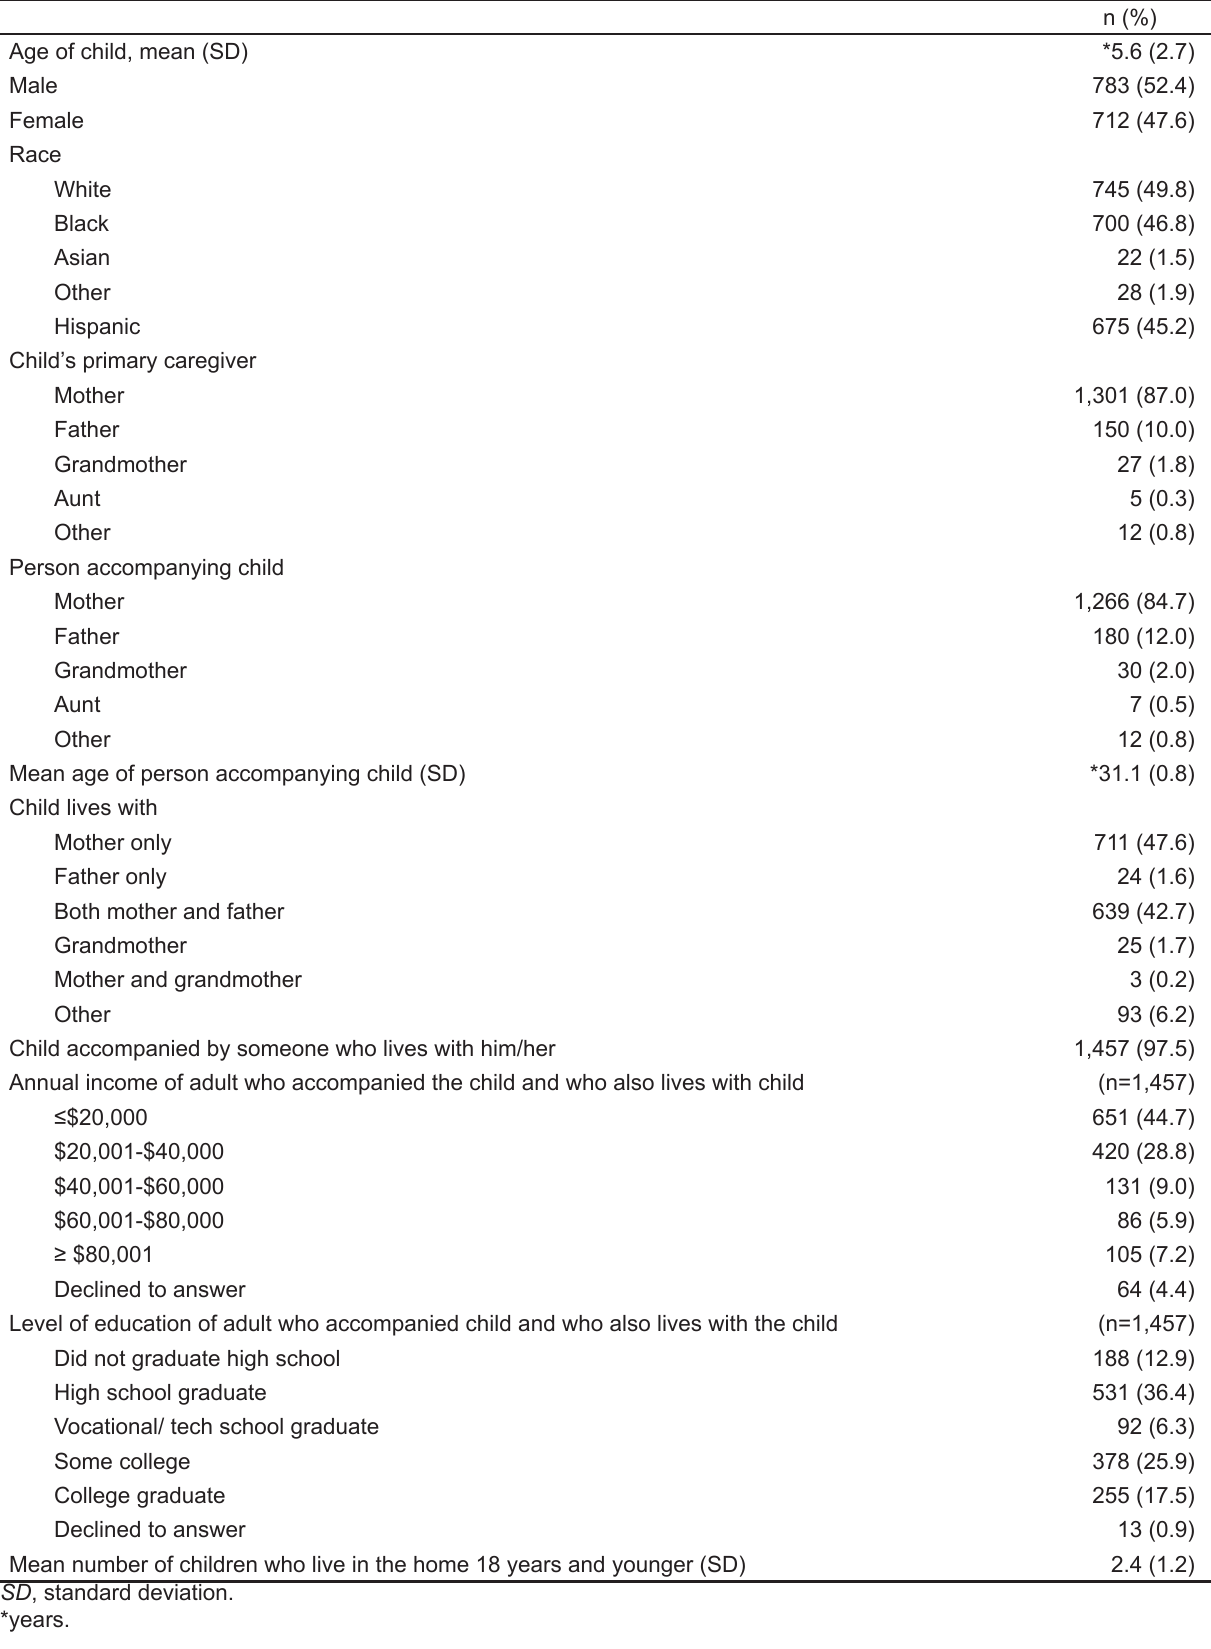
Table 1. Characteristics of participants